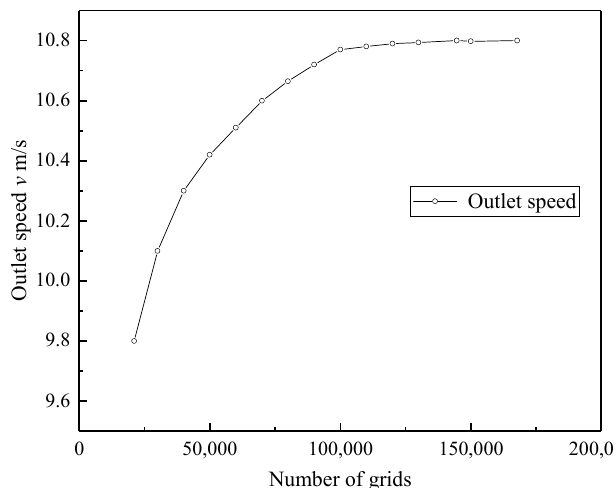
Figure 2. Grid sensitivity test.